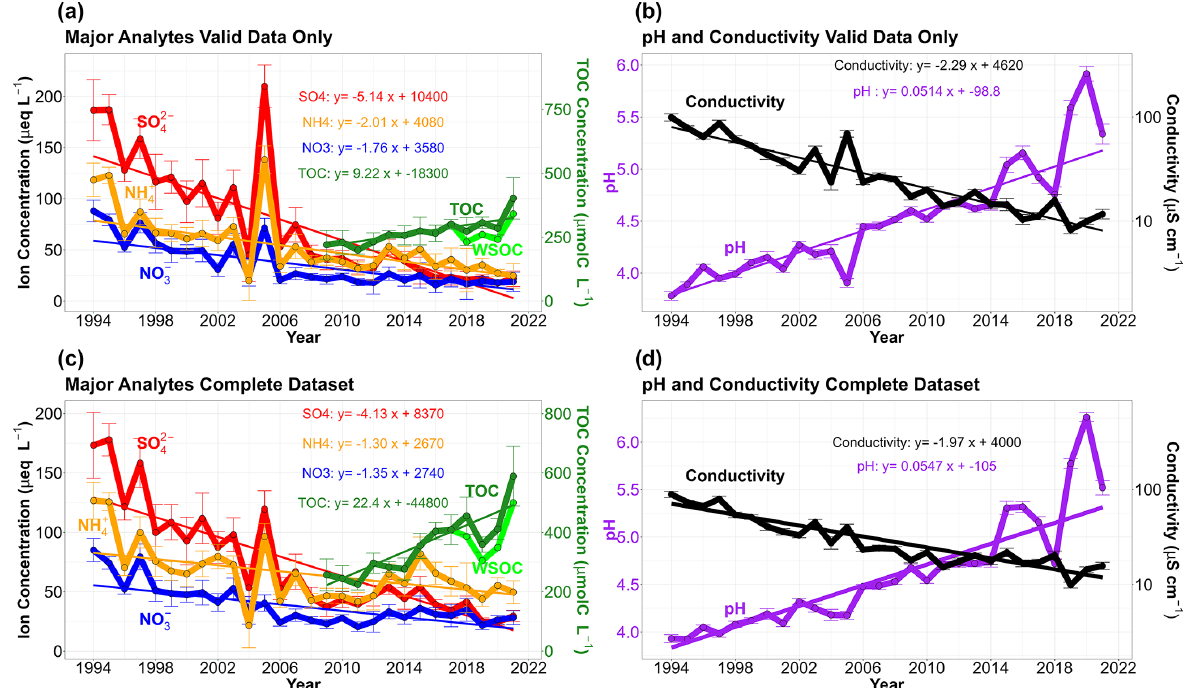
Figure 3. Annual median trends in cloud water collected from the summit of WFM. Panels (a) and (b) include valid data, samples achieving an approximate ion balance, while panels (c) and (d) include the entire available dataset. Annual median trends in major analyte concentra- tions reported in µeqL − 1 for ions on the left axis and µmolCL − 1 for TOC on the right axis. Conductivity is measured in µScm − 1 on the right axis in panels (b) and (d) . Measured annual median WSOC for samples collected in 2018–2021 are shown in light green for comparison to the estimated TOC concentrations in these years. Error bars represent the standard error of the annual mean concentrations. Standard error of the annual mean were used instead of interquartile range as the large sample to sample spread in the cloud water composition produced large error bars, making the figures difficult to read.